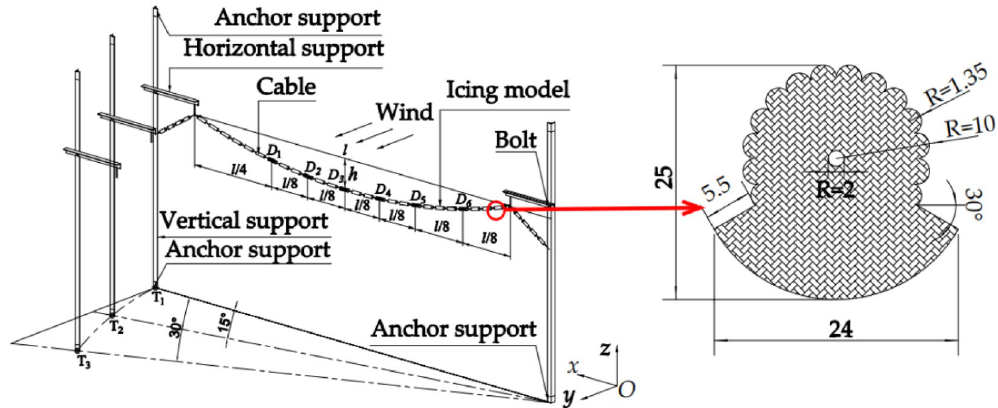
Figure 2. Schematic diagram of model installation, wind direction and fan-shaped icing